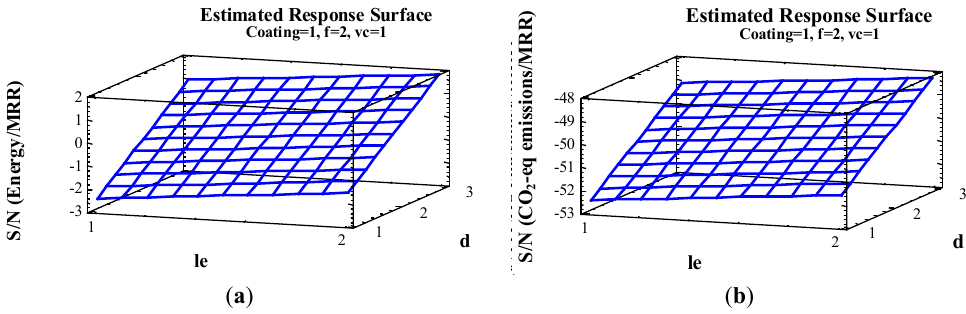
Figure 7. ( a ) Values of the S/N ratio (Energy/MRR) with respect to le and d ; ( b ) Values of the S/N ratio (CO 2 -eq emissions/MRR) with respect to le and d .